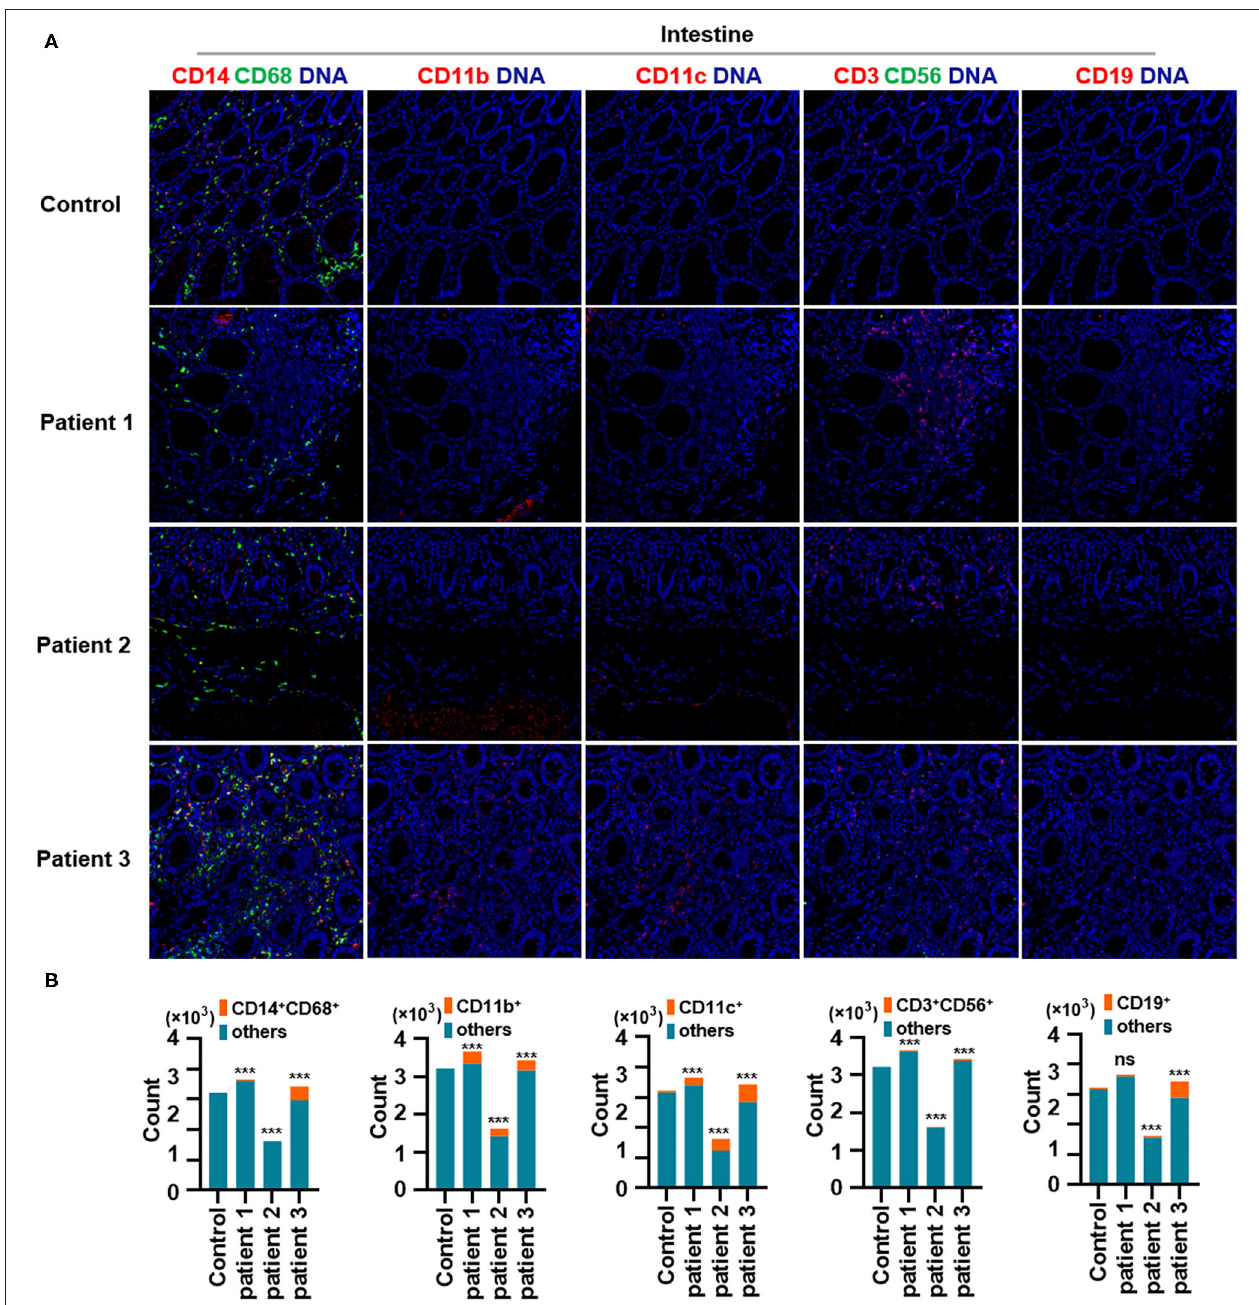
FIGURE 3 | Immune cell responses to severe acute respiratory syndrome coronavirus 2 (SARS-CoV-2) in the intestine of patients with coronavirus disease-2019 (COVID-19). (A) Monocytes (CD14 and CD68), CD11b + macrophages, CD11c + dendritic cells (DCs), natural killer T (NKT) cells (CD3 and CD56), and B cells (CD19) in the intestine of controls and three patients with COVID-19. (B) Bar plot for the comparison of monocytes (CD14 and CD68), CD11b + macrophages, CD11c + DCs, NKT cells (CD3 and CD56), and B cells (CD19) in the intestine of controls and three patients with COVID-19. The significance of differences between groups is shown as horizontal brackets and was assessed using Fisher’s exact test. *** P < 0.01; ns, P >